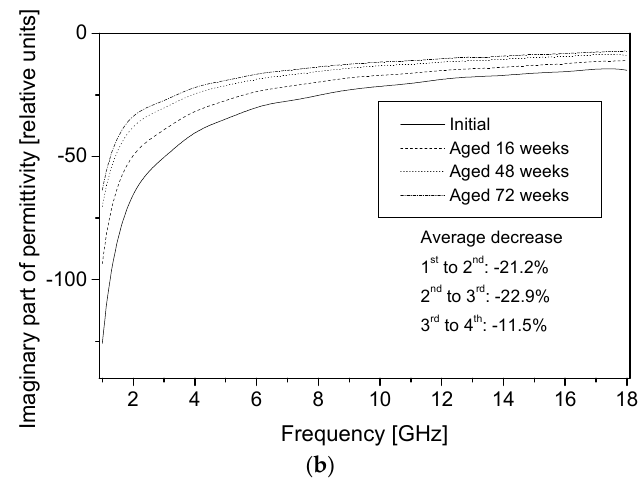
Figure 6. ( a ) Real part of permittivity for PPy- p TSA–coated Nylon-Lycra. Polymerisation time: 180 min, concentration: 0.018 mol/L; ( b ) Imaginary part of permittivity for PPy- p TSA–coated Nylon-Lycra. Polymerisation time: 180 min, concentration: 0.018 mol/L.